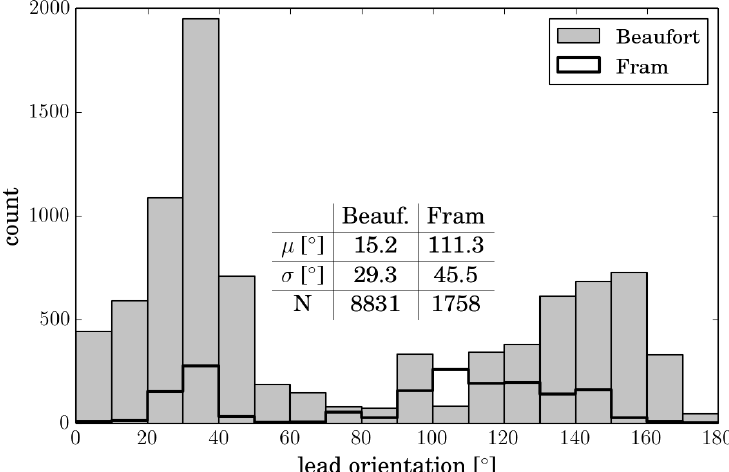
Figure 14. Histogram of lead orientations in sub regions of the Beaufort Sea (gray) and the Fram Strait (black solid line) from 2002 to 2011. The precise locations of the two sub regions are shown in Figure